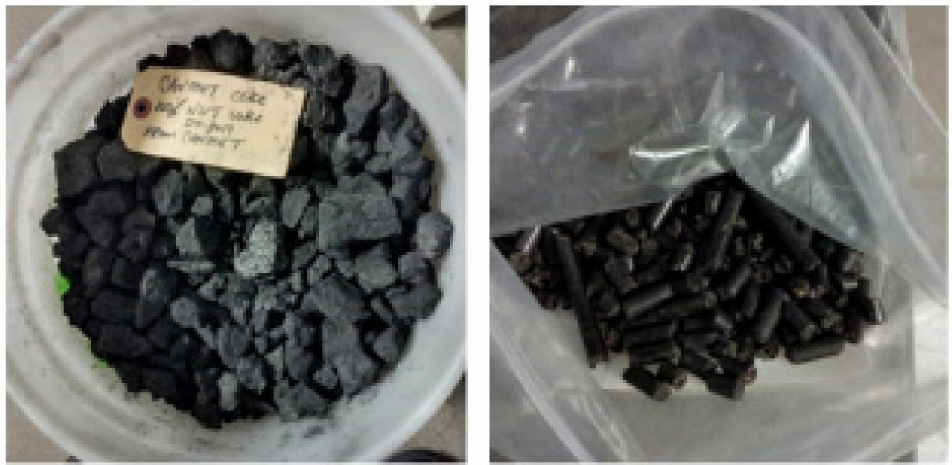
Figure 1. Appearance of nut coke ( left ) and torrefied wood pellets ( right ).